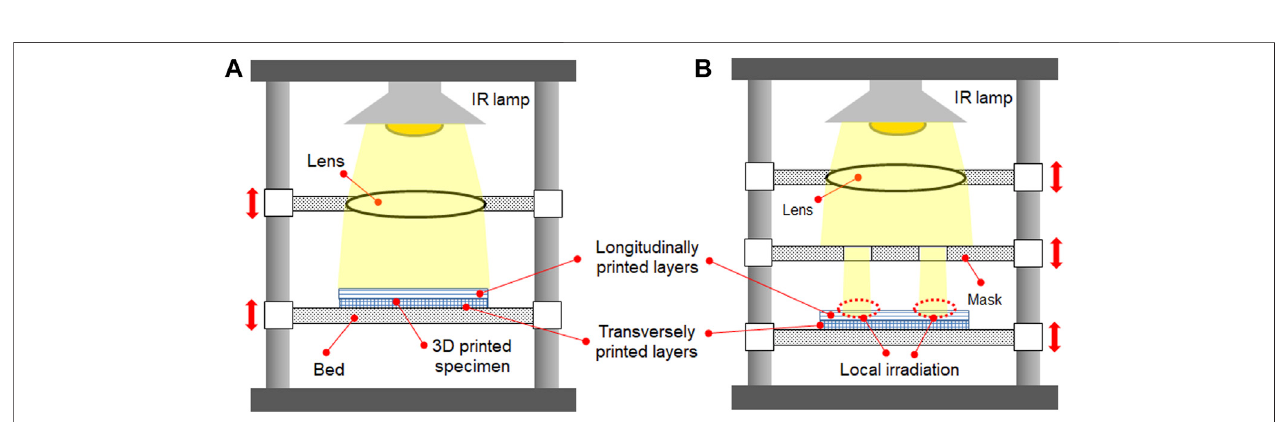
FIGURE2| Con fi gurationoftheIRheatingsystemforthermoresponsiveshapetransformation (A) GlobalIRirradiation (B) LocalIRirradiationusingapro fi ledmask.